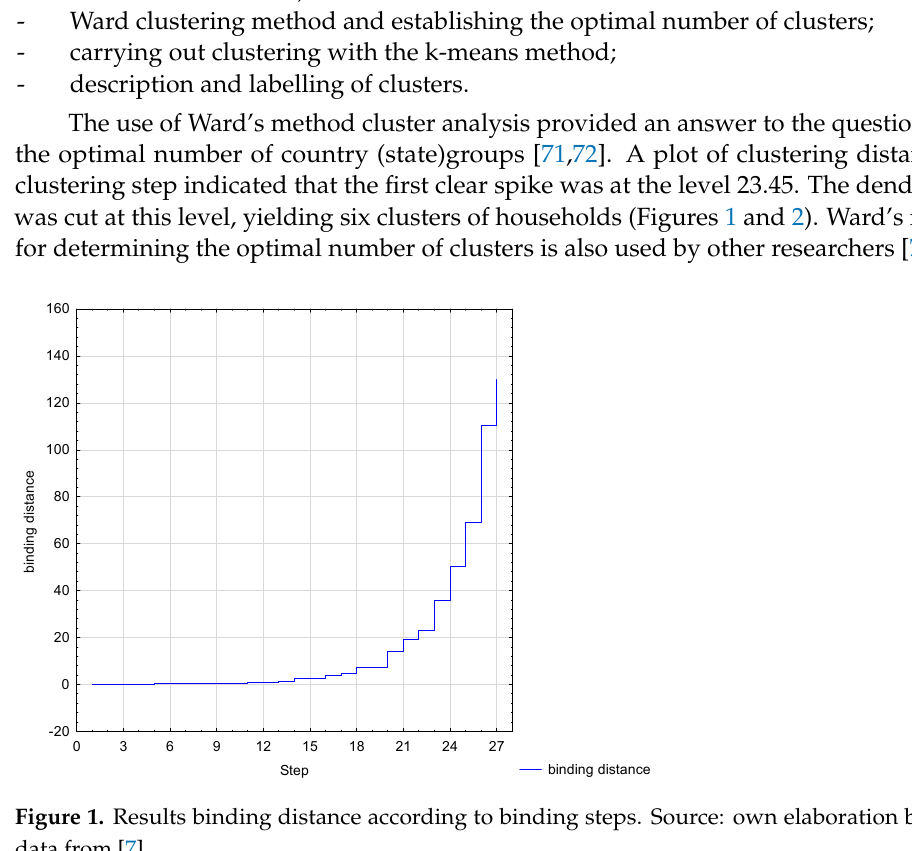
020406080100120140 23 Figure 2. Results of the hierarchical grouping of similarities between the EU countries in final energy consumption from renewable energy sources in households’ sector in 2019 using the Ward’s method. Source: own elaboration based on data from [7]. Then, the k ‐ means method was used to group countries. K ‐ means cluster is widely described in the literature on the subject [74–77]. The algorithm for the k ‐ means method is presented in theorem 1. Theorem 1 . The algorithm for the k ‐ means method